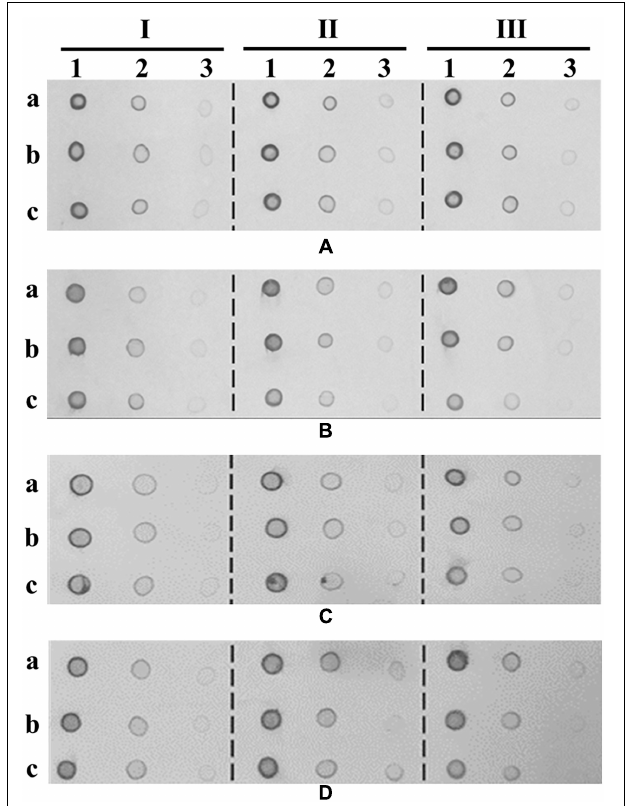
FIGURE 6 | Dot-ELISA assay with T7-Tag R (cid:13) monoclonal antibody. Phage particles recycled after optimization of cultivation process were detected by Dot-ELISA with T7-Tag R (cid:13) monoclonal antibody. (A) T7-wt cultivation. (B) T7- (cid:52) holin-F1 cultivation. (C) T7- (cid:52) holin-F10 cultivation. (D) T7- (cid:52) holin-F20 cultivation. Columns I, II, and III represent the initial host cell density of OD 600 nm = 0.5, 1.0, and 1.5, respectively. Columns 1, 2, and 3 represent the 10-, 100-, and 1,000-fold dilution of each phage sample, respectively. Rows a, b, and c represent the multiplicity of infection values of 0.01, 0.001, and 0.0001,